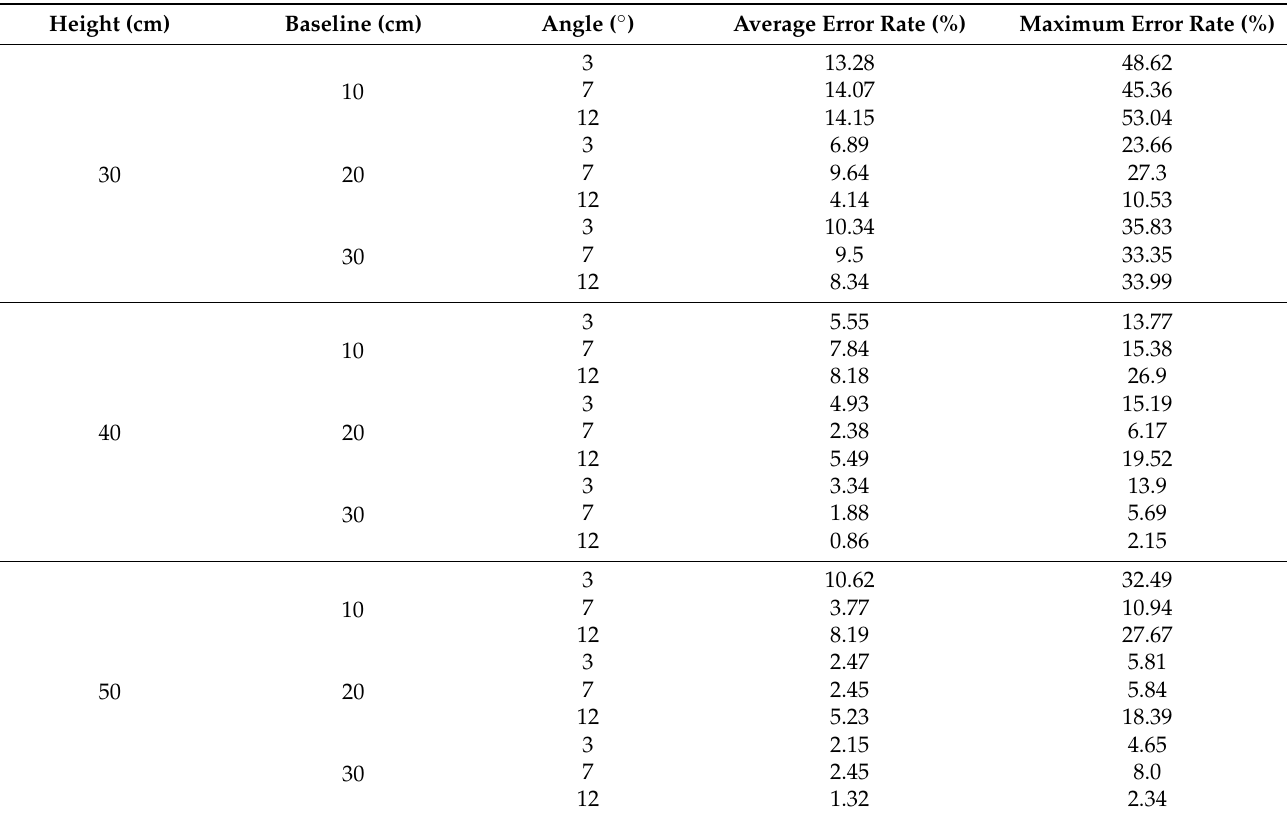
Table 1. Test results for optimization of mounting